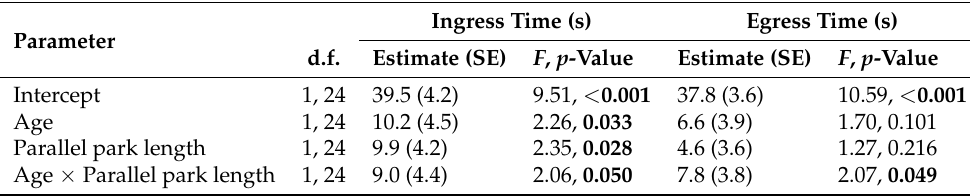
Figure 4. Interaction plots showing the effects of standardized parallel park length on predicted ingress (left panel) and egress (right panel) times at three values of standardized age: − 1 SD (younger), 0 (average), and +1 SD (older). Error bands for each regression line represent 90% confidence intervals. Table 5. Summary results from the reduced linear regression models examining the main and interaction effects of standardized age and standardized parallel park length on ingress and egress times, respectively. Values in bold indicate significant effects at p <